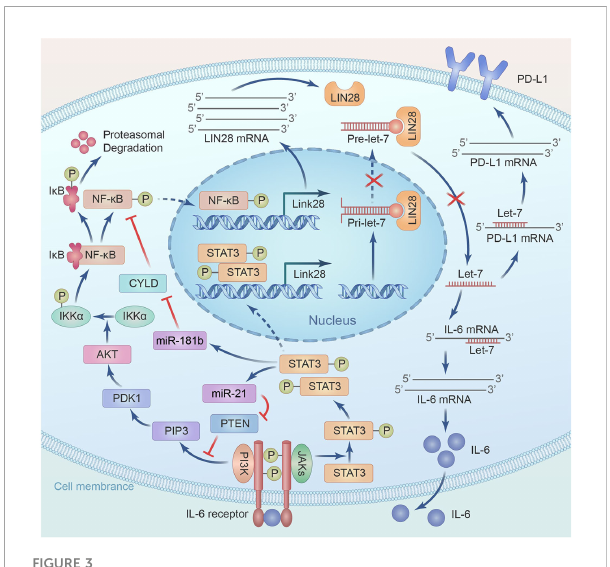
FIGURE 3 A positive feed-back between LIN28/Let7 axis and NF- k B/STAT3 mediates up-regulation of IL-6 and